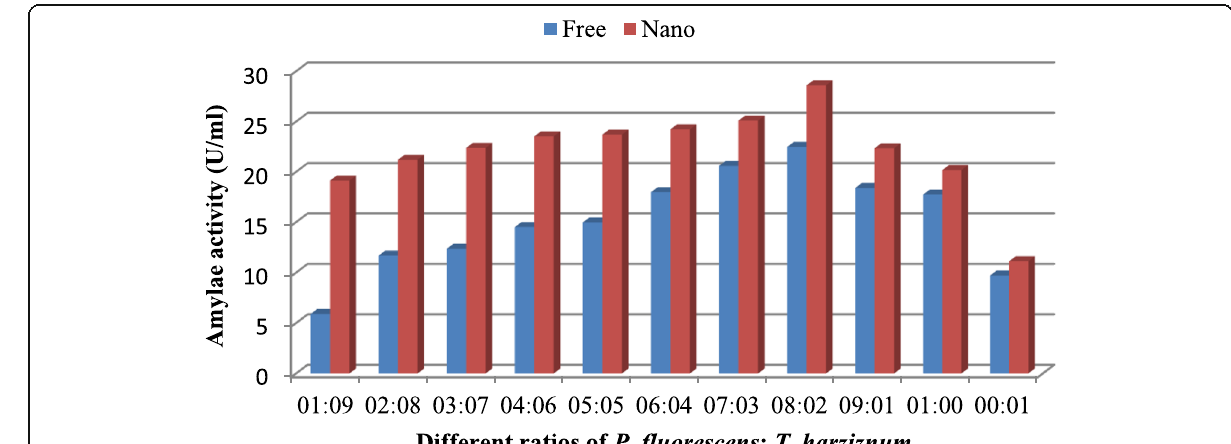
Fig. 1 Effect of different ratios of T. harzianum and P. fluorescens maize